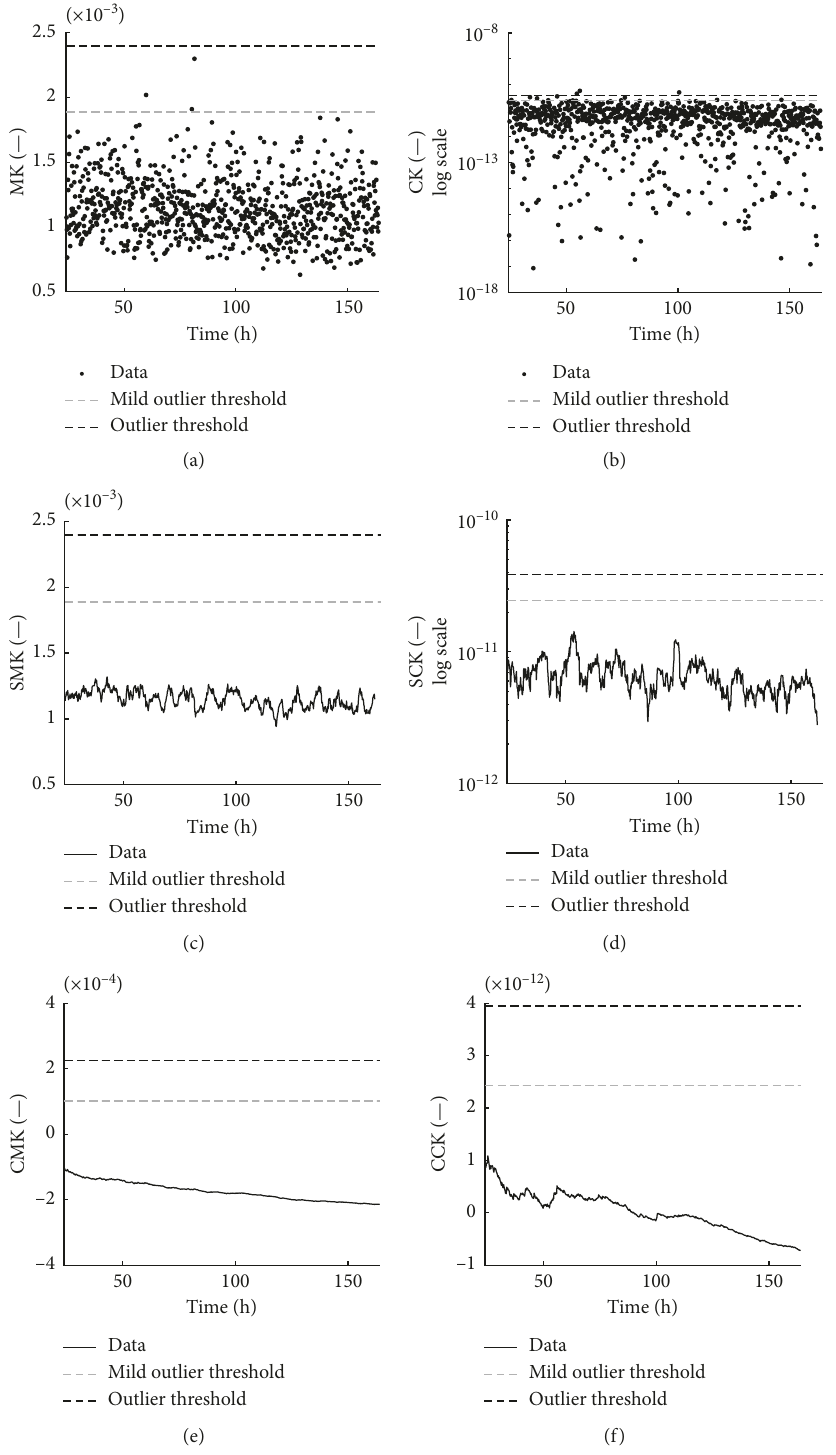
Figure 10: Application of the proposed method considering the rolling element fault frequency starting from (a, c, e) MOMEDA and (b, d, f)